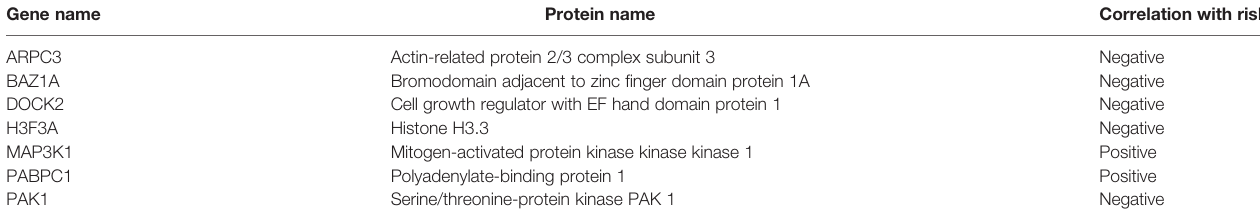
TABLE 3 | Calci fi cation paradox-related genes based on the LASSO